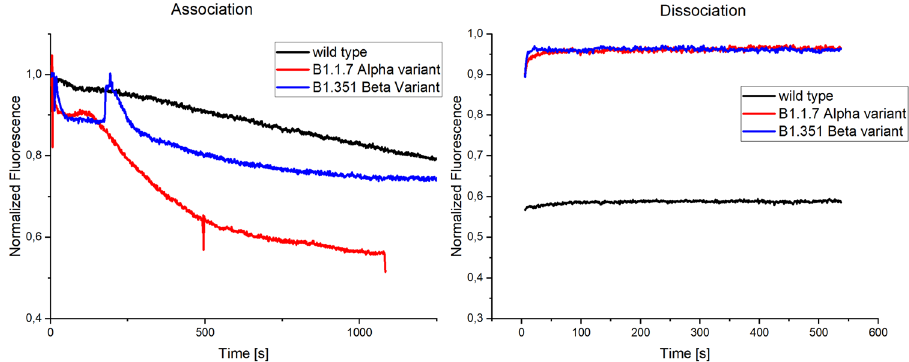
Figure 6. SARS-CoV-2 pseudo virus variants binding to SBP1-peptide. The binding of pseudo viruses that carry spike proteins of three different variants of the SARS-CoV-2 virus to the DNA-peptide nanostructure was determined. Association behavior differed for all three variants. While the wild type showed the typical linear association behavior, Alpha and Beta presented an exponential binding behavior. Spikes in the signal can be attributed to air in the channel system. The Alpha variant induced the strongest signal change over the measurement time. The dissociation displayed almost no signal change for all three